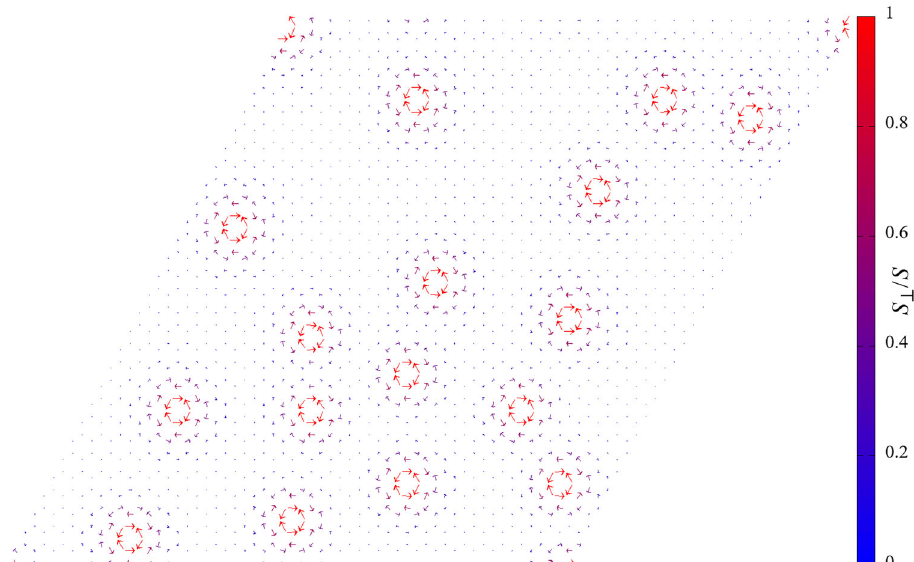
Fig. 1 Classical magnetic vortex liquid. A random vortex con fi guration obtained via classical simulated annealing, at φ / π = 0.2 and h / S = 1.12, on a lattice of 30 × 30 × 2 sites with periodic boundary conditions. The [111] direction points out of plane, along which most spins are polarized. Color of the spins indicates the magnitude of the (normalized) transverse magnetization S ⊥ / S . Classical magnetic vortex liquid is a degenerate manifold of many random vortex con fi gurations like this. More random vortex con fi gurations can be found in Supplementary Figs. 1 –